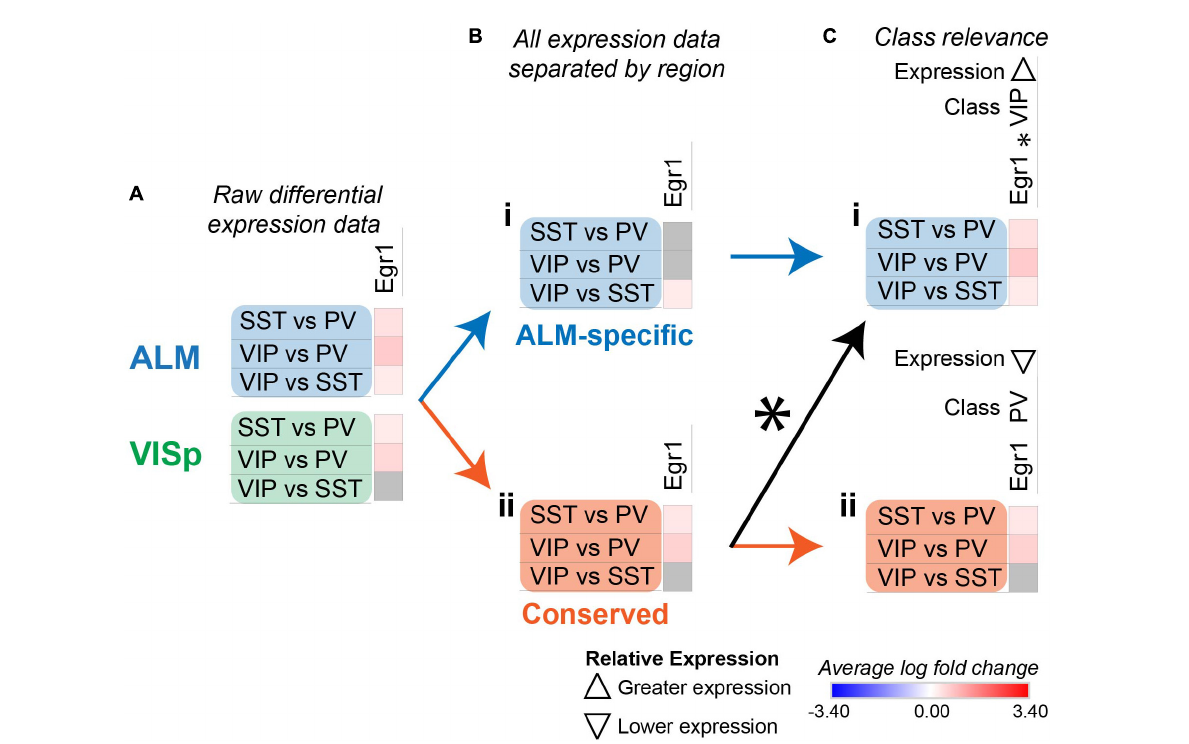
FIGURE6 Strategy to identify class-relevant genes that describe both conserved and region-specific relationships. Each row (e.g., SST vs. PV) presents the results of differential expression tests between neuronal classes. Differential expression results are always relative to the first neuronal class in a comparison (e.g., SST in ‘SST vs. PV’). Gray indicates no significance in differential expression. Shades of red and blue indicate the log fold change of average expression for tests that were statistically significant. (A) Example differential expression test results for egr1 in both ALM and VISp. (B) Separation of differential expression results into subsets that are ALM-specific (Bi) and conserved in both ALM and VISp (Bii). (C) Annotation of erg1 using an asterisk ( ∗ ) to denote that a subset of ALM-specific differential expression results (Ci) is also found within the set labeled as “Conserved” (Cii) . Note that for erg1 , the relevant class and relative expression-level are different in Ci and Cii because the combinations of differential expression results among neuronal classes are unique. Up and down arrows denote whether expression is higher or lower relative to the other